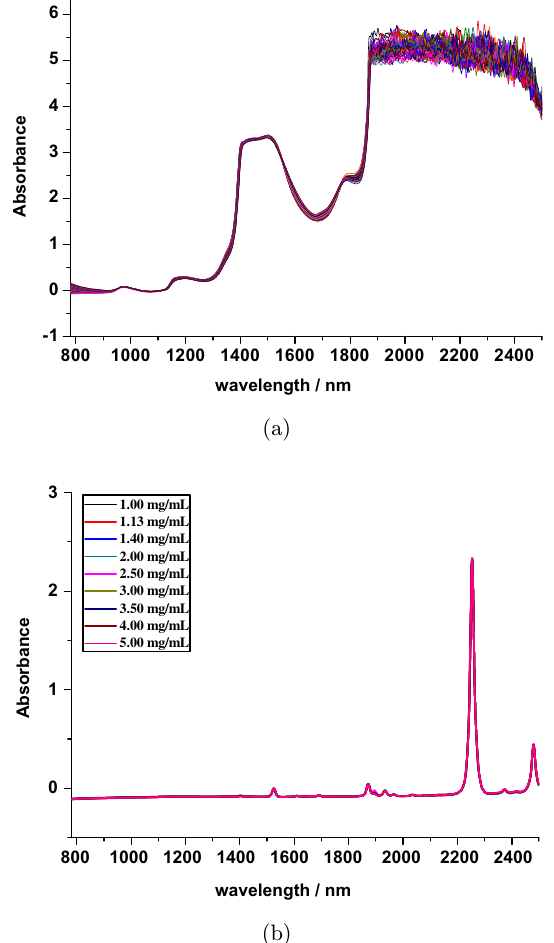
Fig. 2. The raw spectra of Yunkang Oral Liquid (a) and Isopsoralen dilute in deuterated chloroform (b).